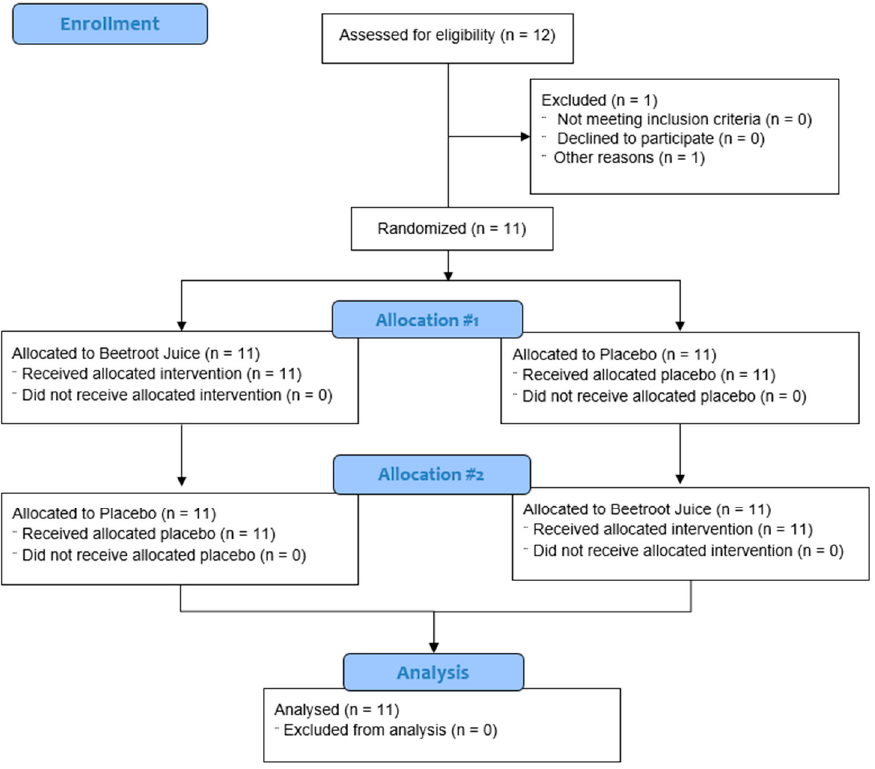
Figure 1. Flow diagram utilizing Consolidated Standards of Reporting Trials (CONSORT) guidelines. Differences were found in the RMSSD during exercise with a lower value in the consumption of BJ vs. placebo (BJ: 12.9 ± 6.3 vs. placebo: 26.9 ± 18; p = 0.023; ES = 0.999). There were no differences in the post-exercise RMSSD (BJ: 26.5 ± 16 vs. placebo: 27.7 ± 28.7; p = 0.914; ES = 0.050) (Figure 2). There was an interaction time x supplementation between the first and final measurement in RMSSD ( p = 0.041; η 2 p = 0.354). Therefore, there were differences in the RMSSD-Slope (BJ: 3 ± 3 (very good) vs. placebo: 0.5 ± 0.7 (acceptable); p = 0.025; ES = 1.104). Table 1. Systolic and diastolic blood pressure basal and post-exercise, and heart rate during re- sistance exercise.